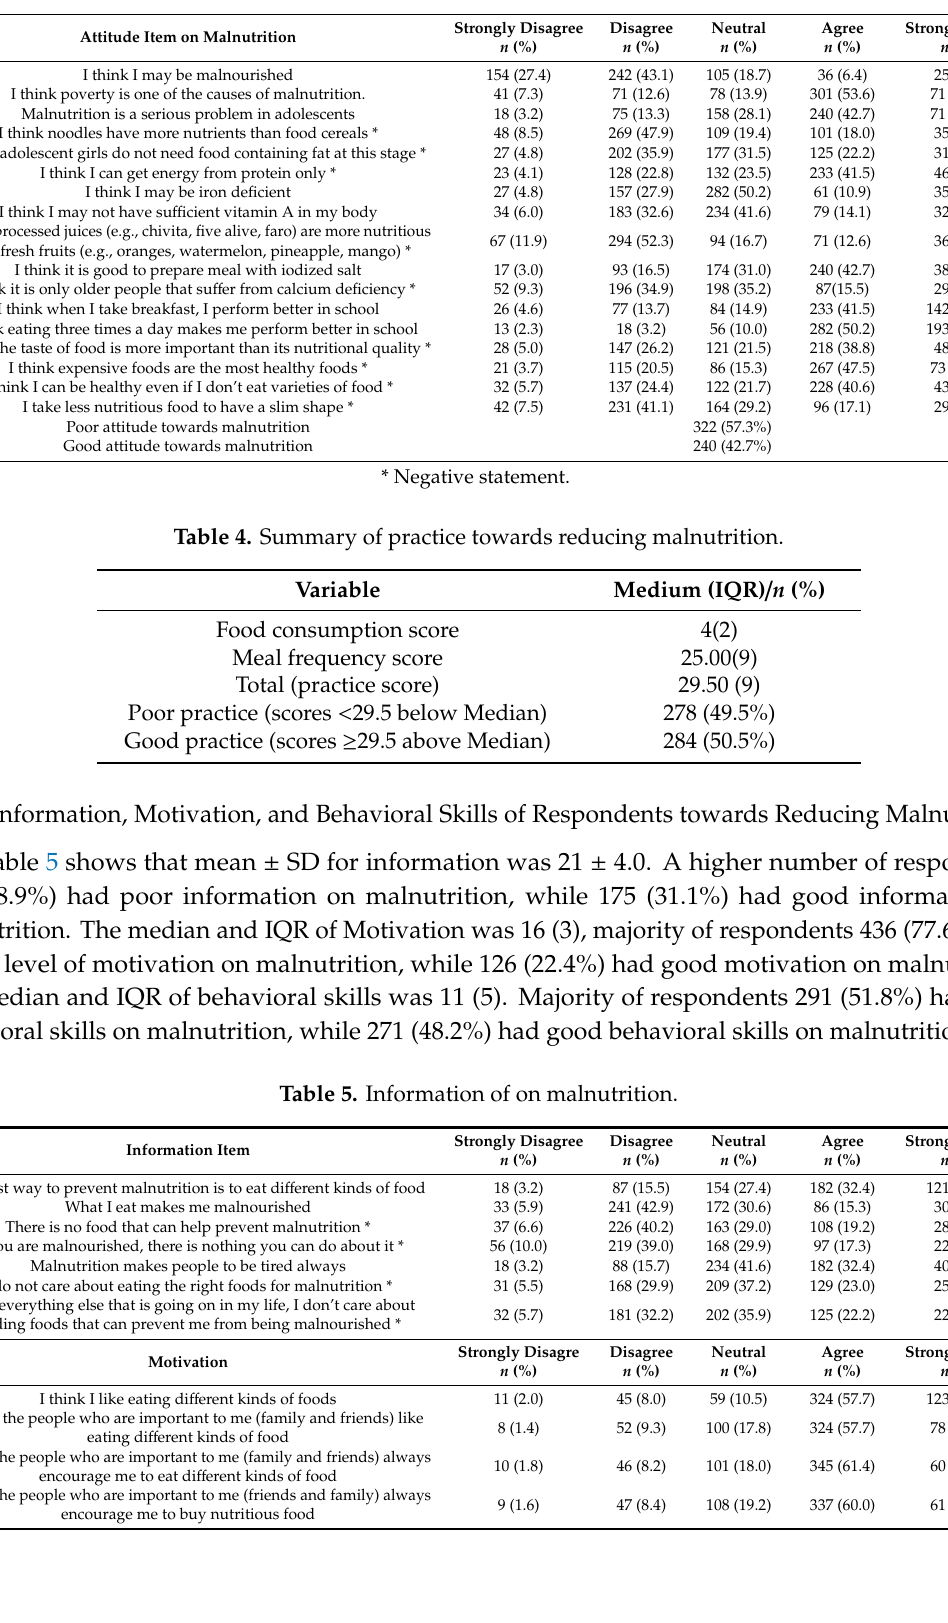
Table 3. The distribution of responses to attitude statements on malnutrition.